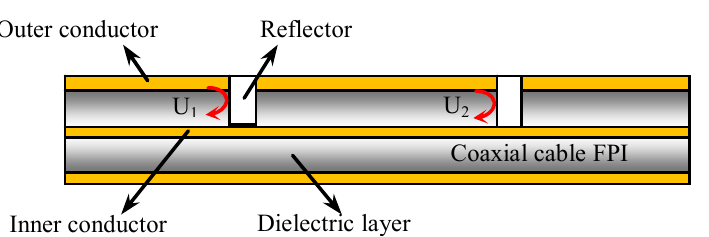
Figure 2. Schematic of a